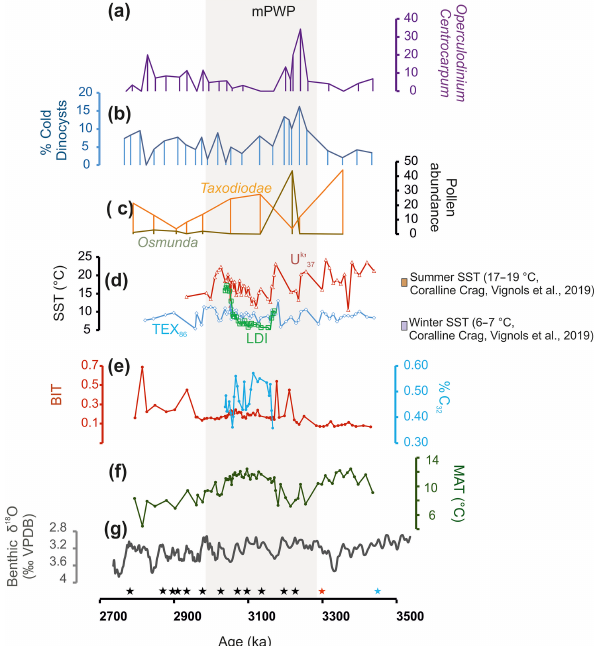
Figure 6. Climate proxy records for the southern North Sea basin for the late Pliocene. Age tie points (stars) based on oxygen isotope stratigraphy (black), sequence boundary correlation (red), and bios- tratigraphy (blue) are indicated. The depth interval covered by the age tying points is 206–330m. (a) The relative abundance of Oper- culodinium centrocarpum expressed as a percent total of dinocysts; (b) percent of cold dinocysts; (c) pollen abundances for Taxodi- oidae (orange) and Osmunda (dark yellow) as a percentage of the (cid:48) pollen sum; (d) SST records based on the TEX 86 , U K , and LDI 37 proxies, together with estimates (dotted lines) from oxygen isotope measurements of bivalves (Vignols et al., 2019); (e) the relative input of terrestrial organic material to the Hank sediments based on the Branched and Isoprenoid Tetraether (BIT) index (Dearing Crampton-Flood et al., 2018) and the input of fresh water based on the percent of C 32 diol; (f) mean air temperature based on brGDGT- palaeothermometry (Dearing Crampton-Flood et al., 2018); and (g) the benthic oxygen isotope stack of Lisiecki and Raymo